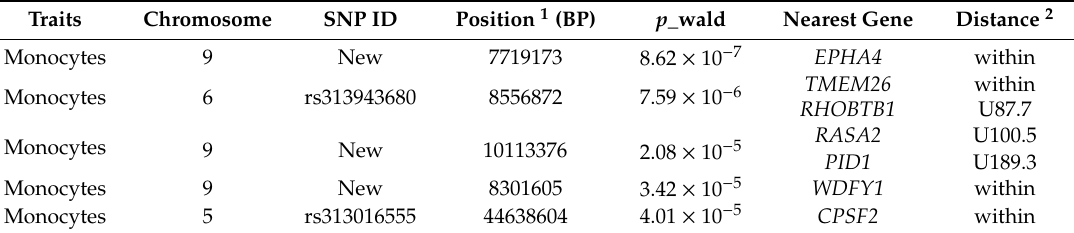
Table 4. SNPs with genome-wide significance for monocyte traits.